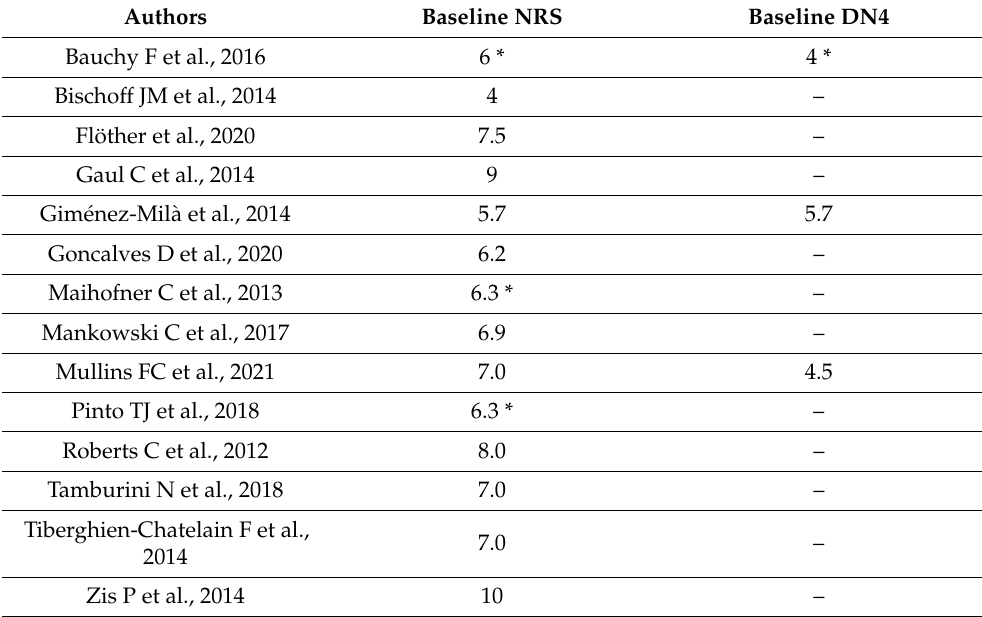
Table 5. Baseline pain